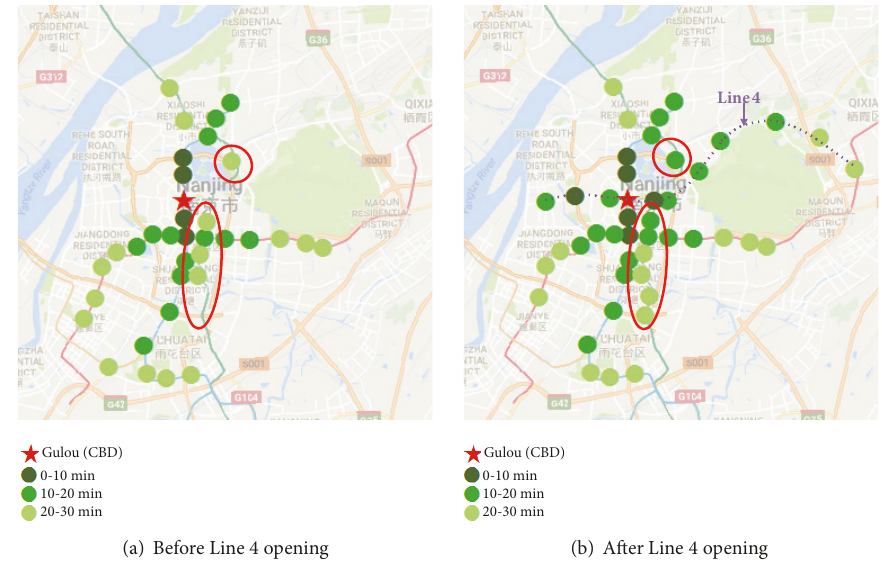
Figure 6: Travel times from metro stations to CBD (map source: Google